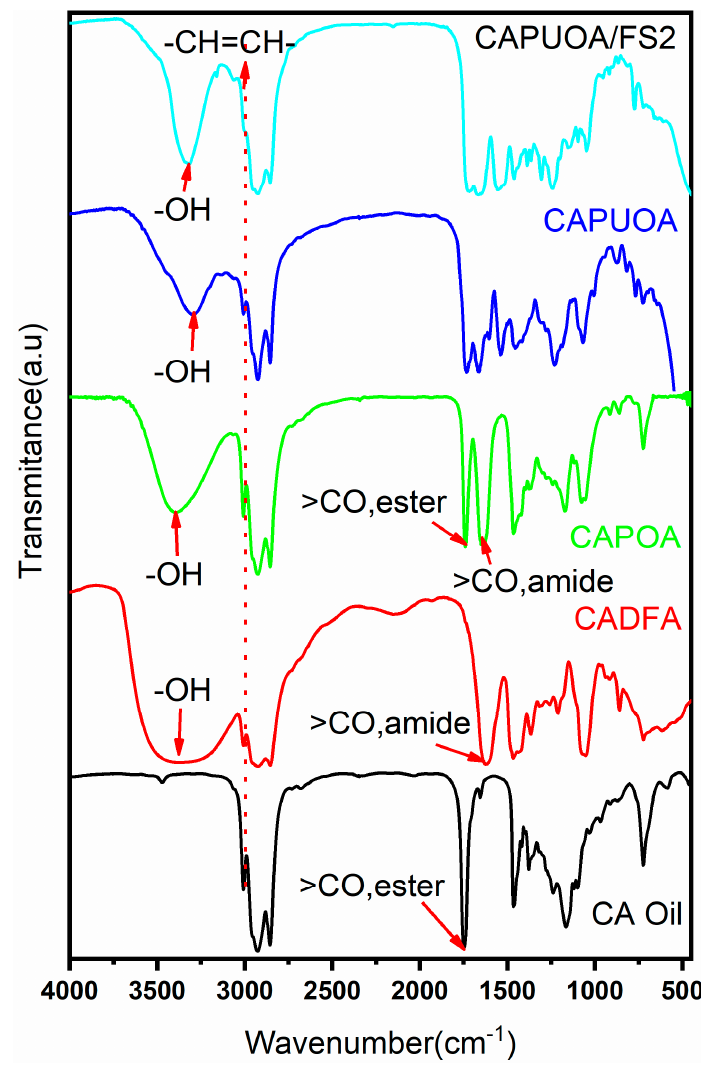
Figure 1. FTIR spectra of CA oil, CADFA, CAPOA, CAPUOA, and CAPUOA/FS2.